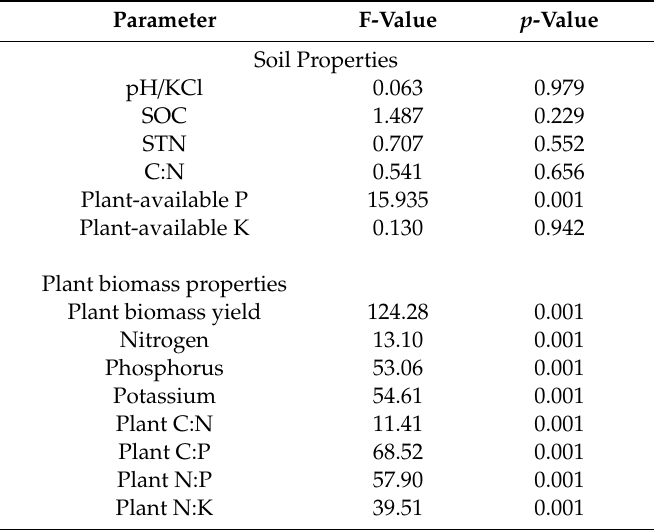
Table 7. E ff ect of treatments on soil and plant properties.